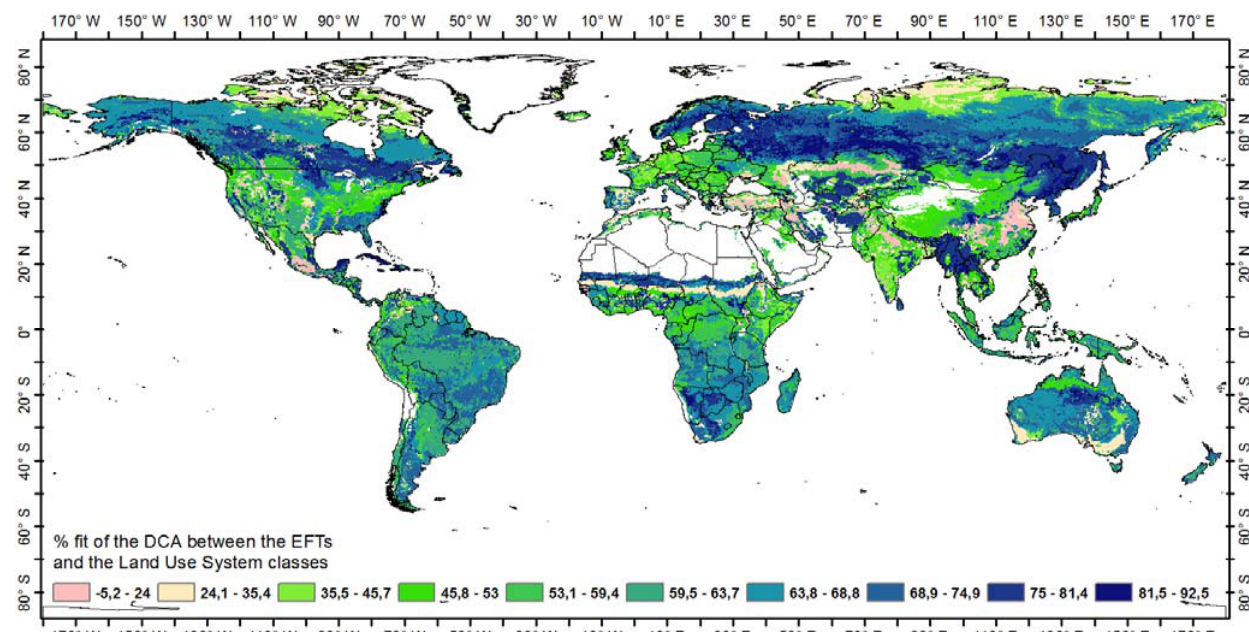
Figure 11. Percentage fit for the DCA of the EFTs with the land Use System classes. High values indicate good fit of the two datasets. White areas represent pixels without vegetation